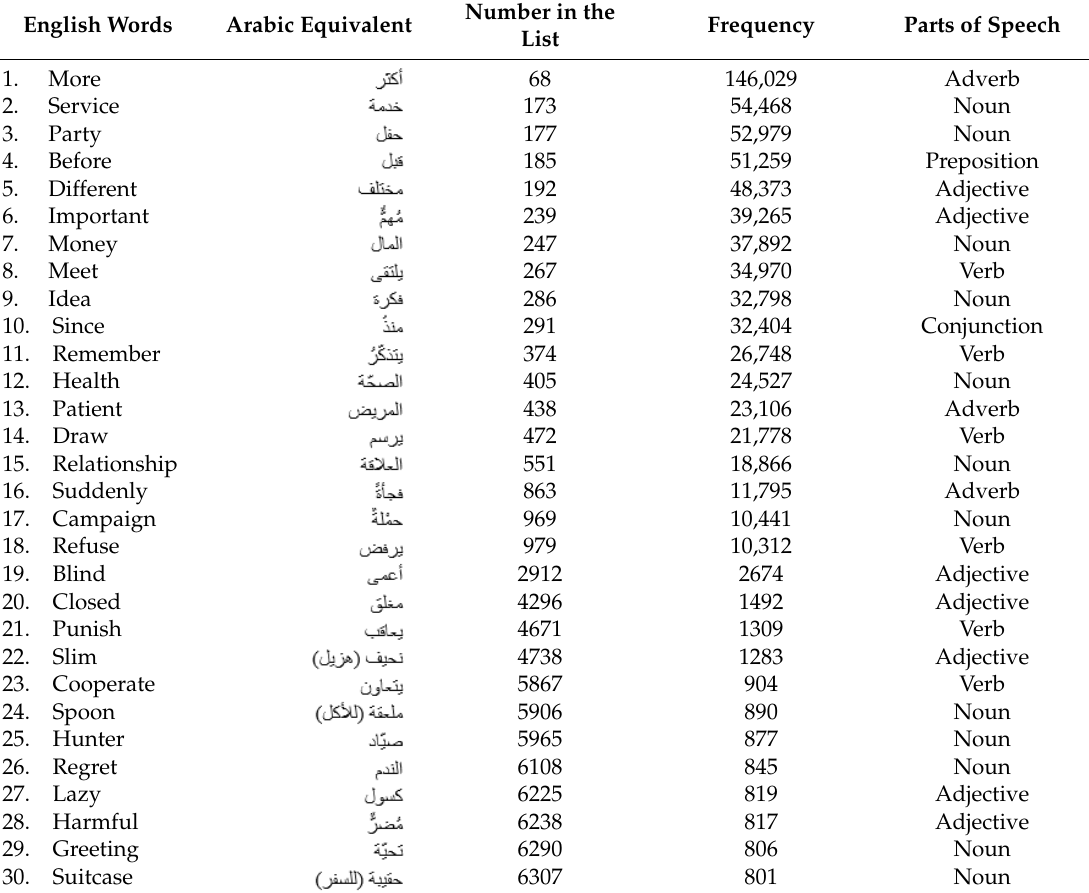
Table 2. Details of the words used in the productive vocabulary knowledge